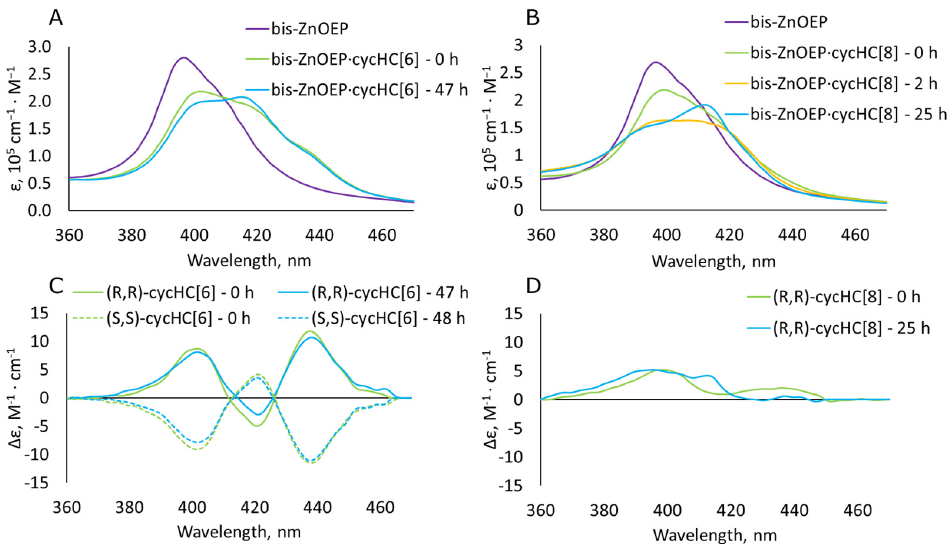
Figure 4. ( A ) Absorption spectra of free bis–ZnOEP (2.2 × 10 − 6 M, CH 2 Cl 2 , 296 K) and after single addition of 3000 eq of ( R , R )- cycHC[6] in time. ( B ) Absorption spectra of free bis–ZnOEP (3.0 × 10 − 6 M, CH 2 Cl 2 , 296 K) and after single addition of 2200 eq of ( R , R )- cycHC[8] in time. ( C ) Change of CD spectra in time corresponding to the sample of bis–ZnOEP ∙ cycHC[6] from absorption spectra A and for the complex with ( S , S )- cycHC[6] measured at the same conditions. ( D ) Change of CD spectra in time corresponding to the sample of bis–ZnOEP ∙ cycHC[8] from absorption spectra B immediately after single addition and after 25 h.